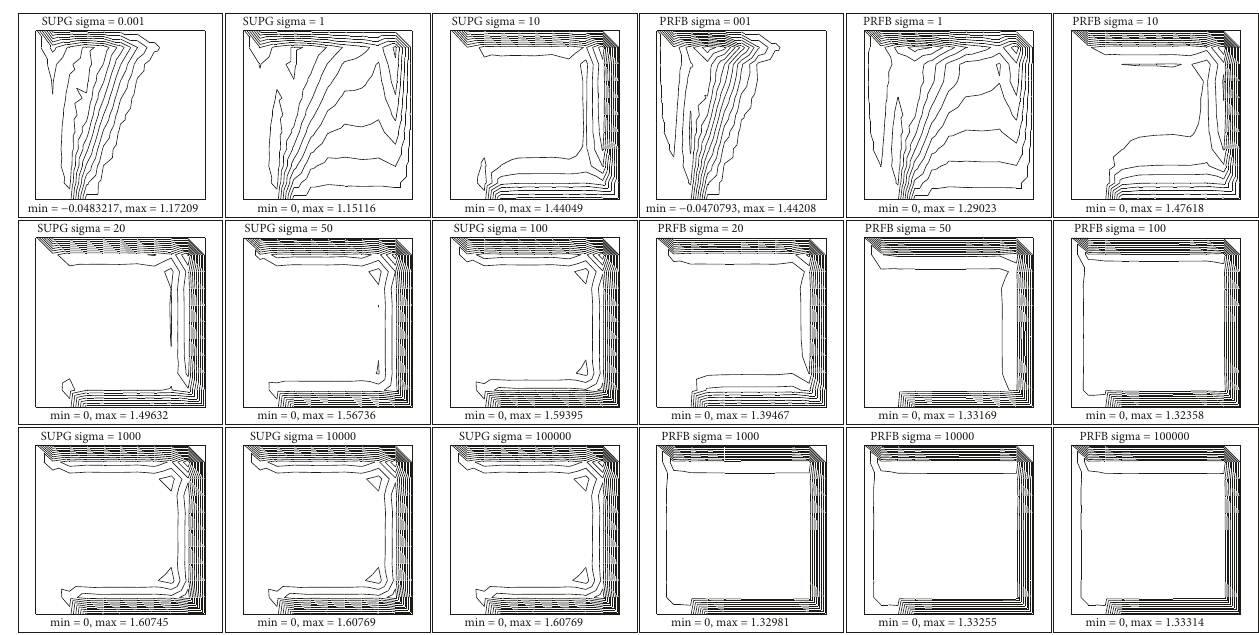
Figure 11: Corresponding contour